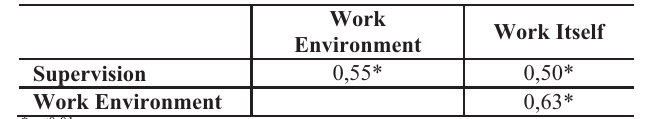
Table 3: Correlation matrix for defined factors